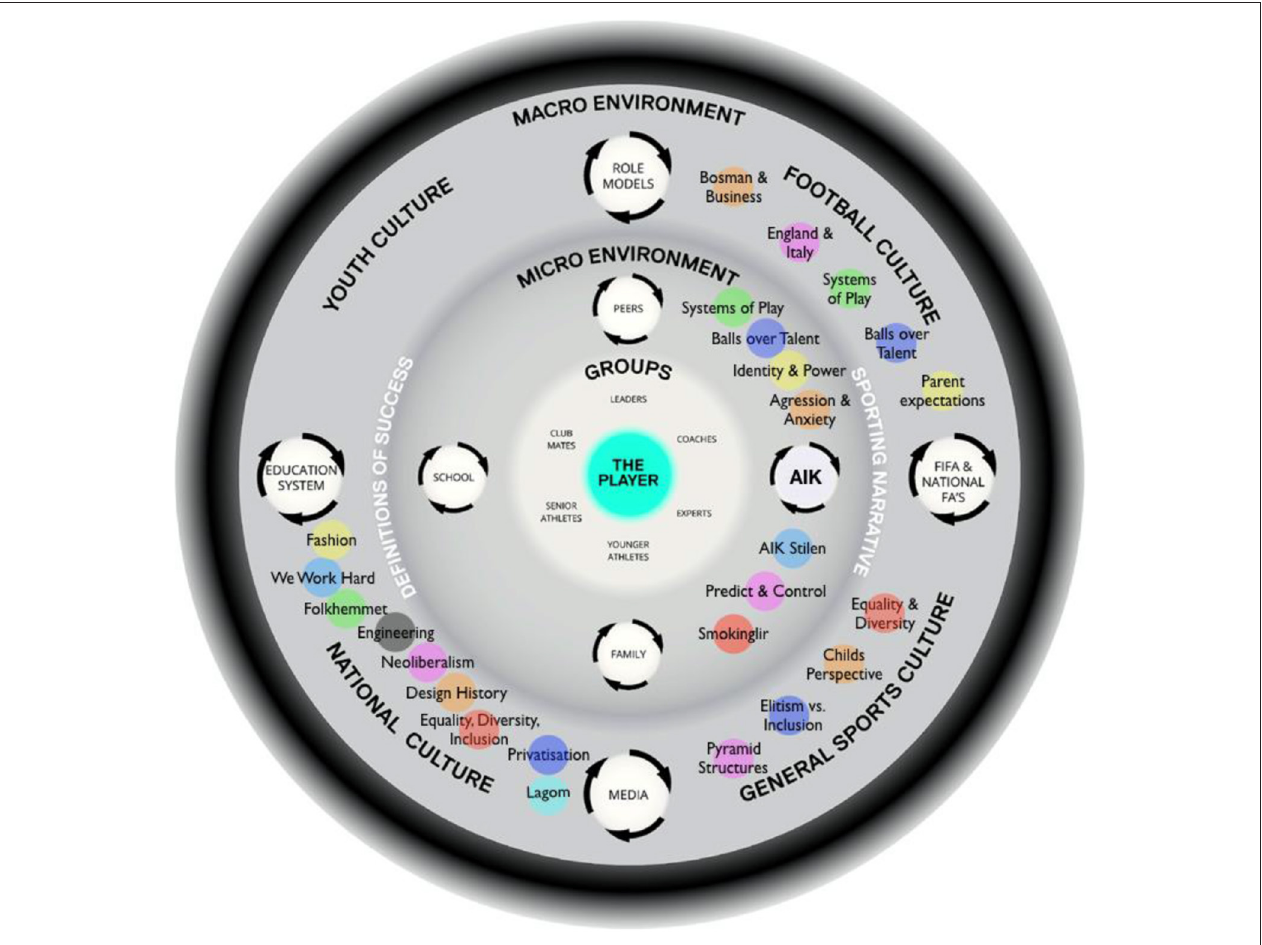
FIGURE 3 | The football in Stockholm ATDE. Themes are embedded in relation to the environment/context (macro or micro) in which the data emerged and cohered. Colors relate to placement on values continuums in later Figures.